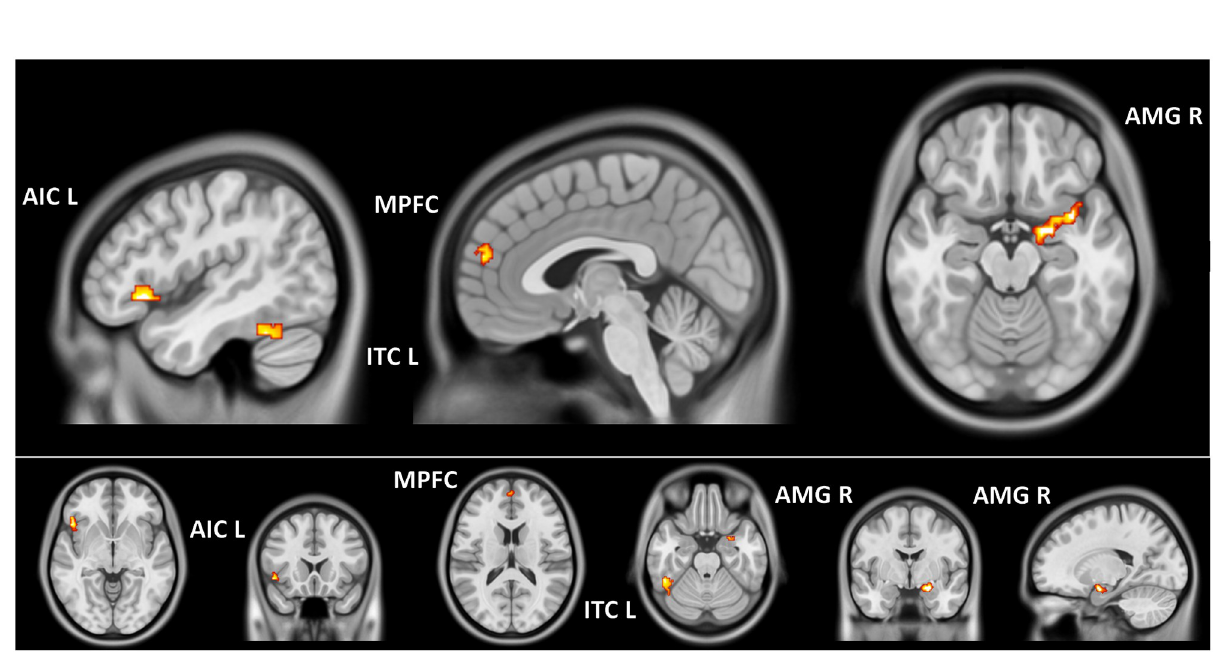
Fig 4. Second-level analysis MVPA. Mean of the three groups for second-level analysis using the SVM weights of all the participants in an ANOVA with three different groups (anorexia, bulimia, controls). Four clusters were important for the different emotions and the neutral conditions: AMG R (right amygdala), AICL (left anterior insula), ITC L (left inferior temporal gyrus), MPFC (middle prefrontal cortex). Clusters depicted on orthogonal projection of an ICBM-152 brain template in neurological convention (p < .05 FWEc).